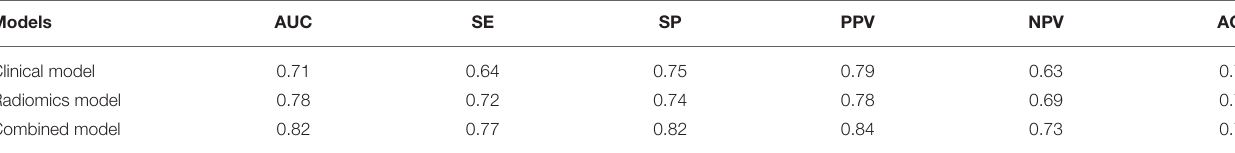
TABLE 2 | Diagnostic accuracy of prediction models.